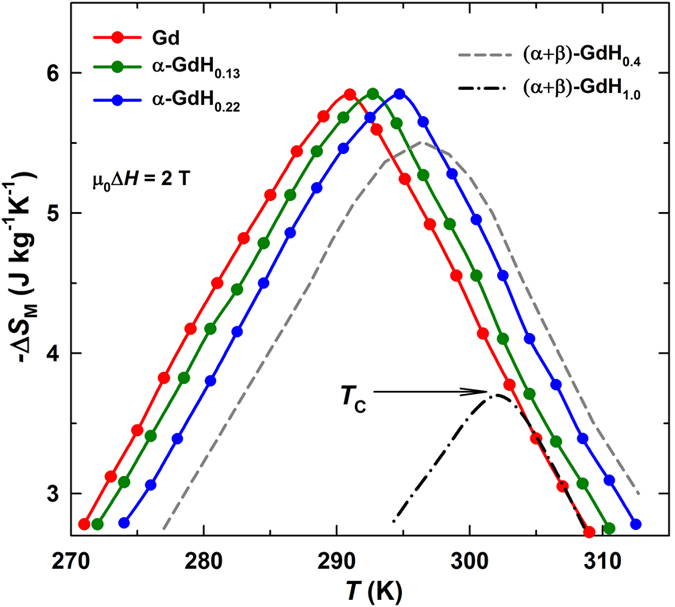
Magnetic entropy change ΔSM vs. temperature for Gd, α-GdH0.13 and α-GdH0.22 at a field change of 2 T.The data for (α + β)-GdH0.4 and (α + β)-GdH1.0 are shown for comparison.